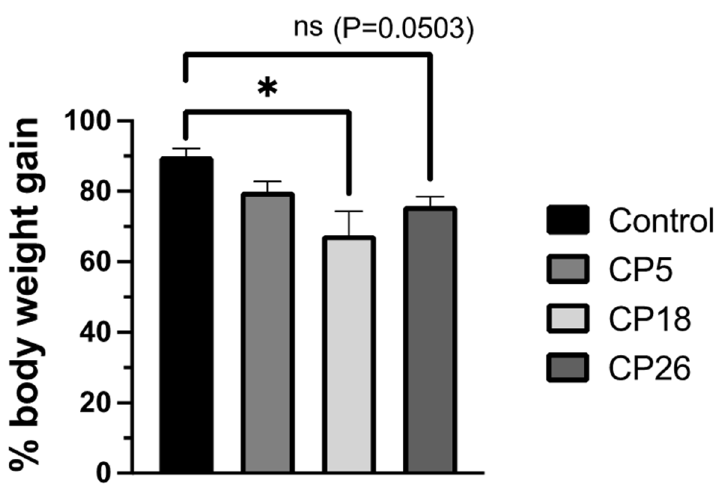
Figure 3 . Effect of C. perfringens on body weight gains. One-day-old commercial broiler chickens were fed an antibiotic-free diet and challenged with one of three different C. perfringens strains, along with the uninfected control, via intracloacal inoculation on day 18 of age, administered twice daily for 4 consecutive days, followed by necropsy on the 5th day. The body weights were collected on day 17 (pre-challenge) and 22 (post-challenge, prior to necropsy) and the percent body weight gain was calculated. Statistical significance between the treatment groups is indicated above the standard error of mean bars. Control—uninfected; CP— C. perfringens strain. An asterisk above the standard error of mean bars between groups indicate the differences were statistically significant at p < 0.05; ns- non-significant.